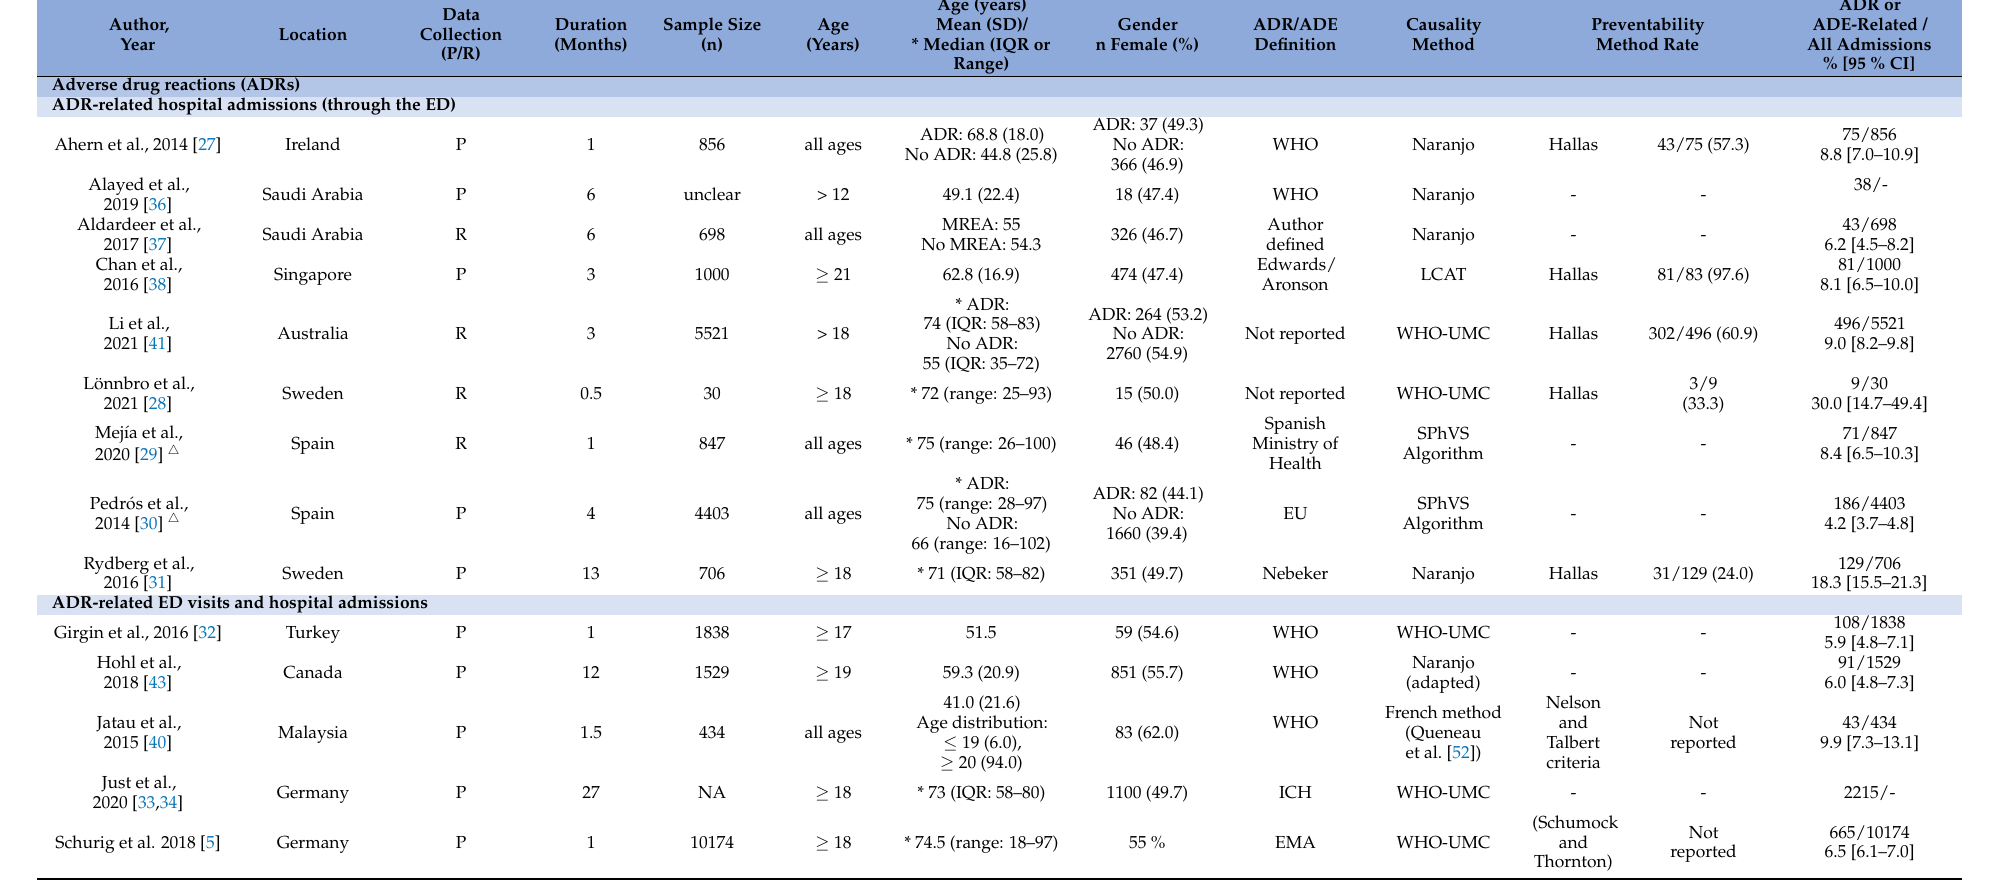
Table 1. Main characteristics of the selected studies on ED visits and/or hospital admissions related to ADRs or